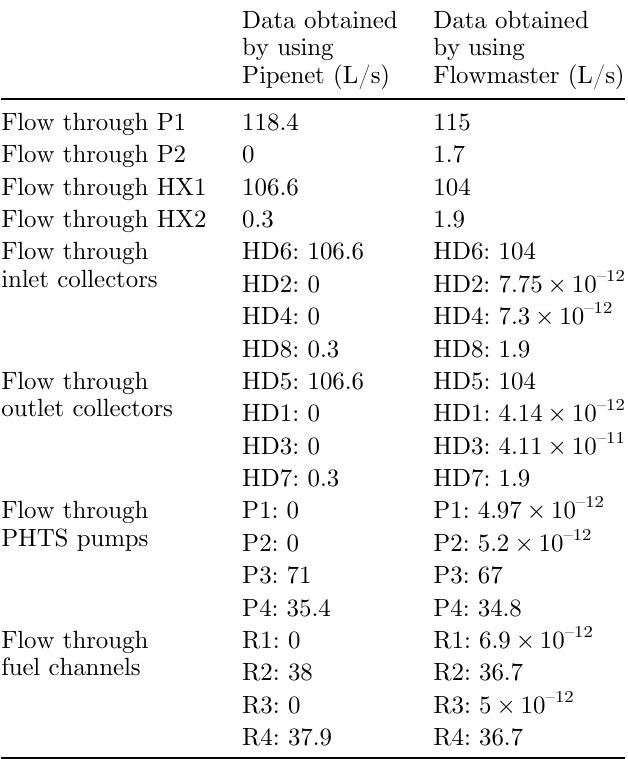
Table 9. Comparative results from the hydraulic analyses. Model II. Data